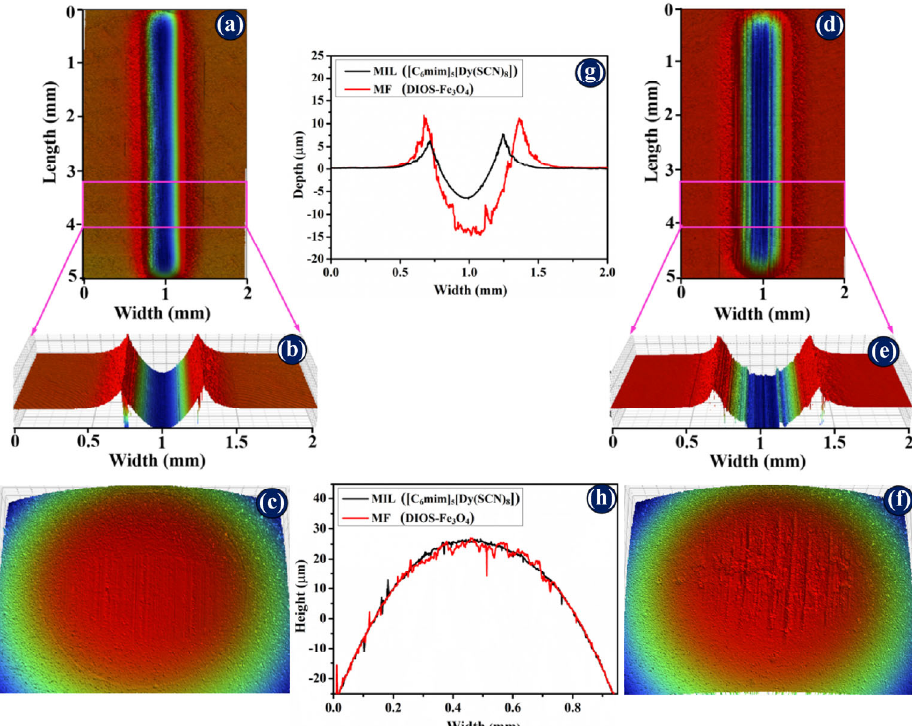
Fig. 9 3D images of wear scars and partially enlarged pictures of wear scars of a steel disk and upper steel ball lubricated by (a–c) the MIL and (d–f) MF, as well as (g, h) 2D contrast pictures of the wear scar depth profile at 100 N and 25 ° C.